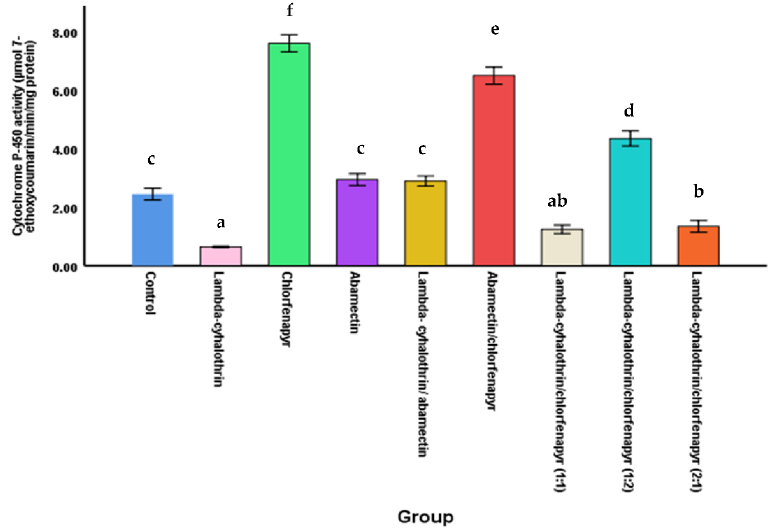
Figure 4. The Cytochrome P-450 activity in M. domestica larvae treated with insecticides alone and combinations. Different letters indicate that the mean of cytochrome P-450 activity within the same column followed by the same letter was not significantly different at p < 0.05 according to Duncan post-host test. A significant decrease of the cytochrome P-450 activity was observed in larvae of M.